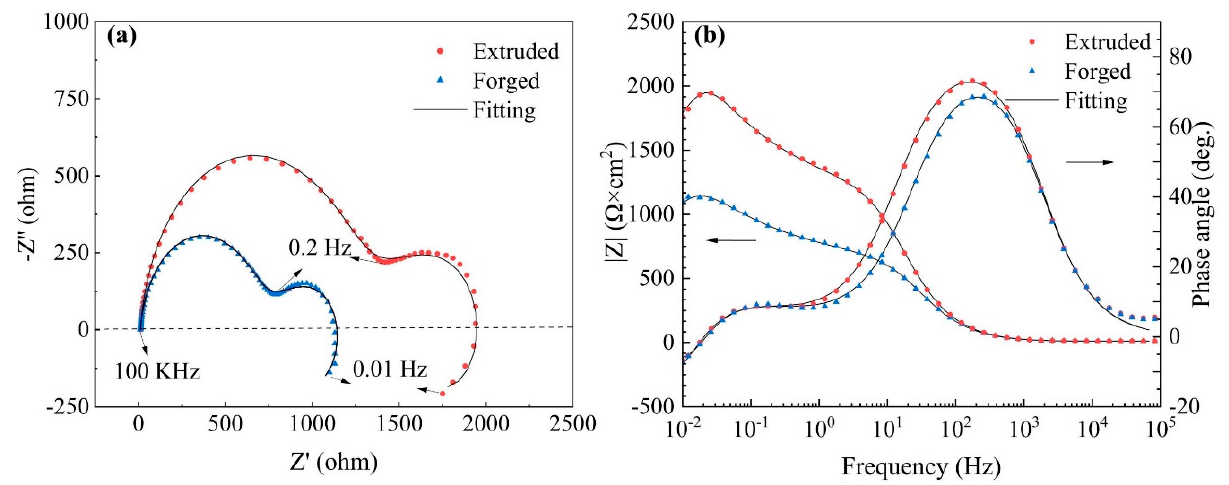
Figure 10. Electrochemical impedance spectrum (EIS) plots of the WE43 alloys: ( a ) Nyquist plots; ( b ) Bode plots.